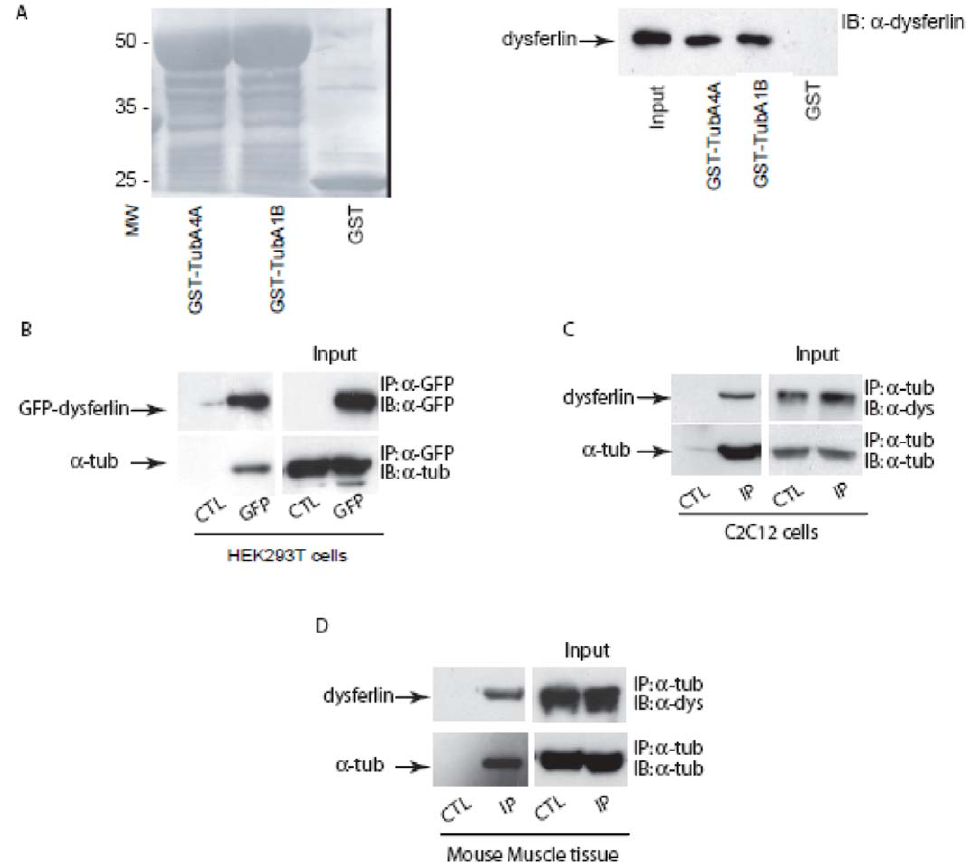
Figure 3. Dysferlin complexes with alpha-tubulin. A. GST, GST-TubA4A and GST-TubA1B fusion proteins immobilized onto glutathione- Sepharose 4B beads were incubated with mouse skeletal muscle homogenate. GST, GST-TubA4A or GST-TubA1B with adsorbed proteins from mouse skeletal muscle were resolved by SDS-PAGE, transferred onto a nitrocellulose membrane, and blotted with mouse monoclonal anti-dysferlin antibody. Left panel: nitrocellulose membrane stained with ponceau red, right panel: detection of immunoreactive dysferlin. B. GFP-dysferlin was overexpressed in HEK293T cells and then immunoprecipitated from cell extracts with anti-GFP antibody. As a control, protein A-Sepharose beads coated with anti-GFP antibody were incubated with extracts of non-transfected HEK293T cells. Proteins were separated on SDS-PAGE gel and were transferred onto a nitrocellulose membrane and blotted with anti-GFP or anti-alpha-tubulin antibodies. Input (right panel), immunoprecipitate (left panel). C–D. Co-immunoprecipitation of dysferlin with anti-alpha-tubulin antibody from C2C12 myotube extracts ( C ) or mouse skeletal muscle homogenate ( D ). Input (right panel), immunoprecipitate (left panel). As a control (CTL), protein A-Sepharose beads were incubated with myotube extracts in the absence of anti-alpha-tubulin antibody.